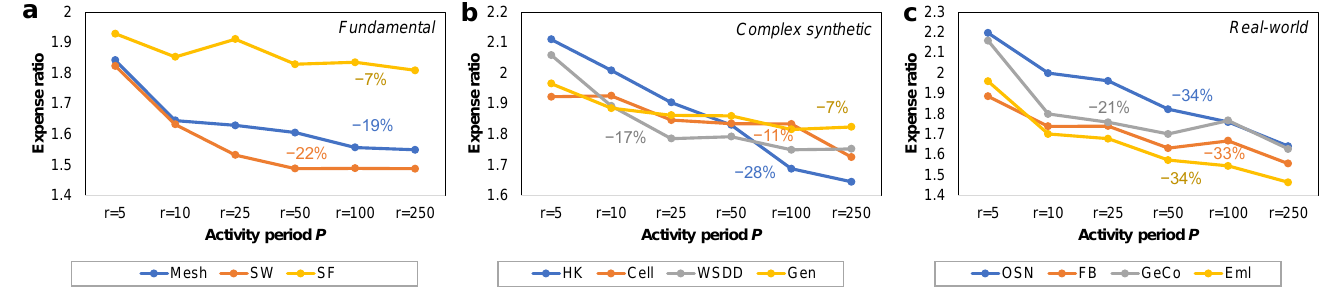
Figure 5. The impact of the spreader activity period P on the expense ratio between the continuous and periodic injection strategies is shown in association with each network topology: ( a ) fundamental networks, except the ER network whose expense ratios are significantly higher ( ≈ 2.5), not shown for graphical reasons; the Mesh and SW networks show similar drops in expense ratio; ( b ) complex synthetic networks—the HK network offers the highest drop in expense ratio as P increases; ( c ) real- world networks—all networks present similar drops in expense